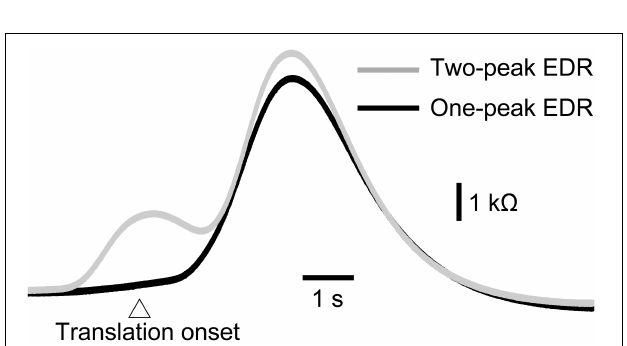
FIGURE 6 | Averaged one-peak and two-peak EDR induced by the self-triggered translation of the support surface across 10 trials in a participant.